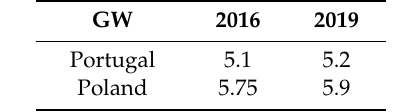
Table 1. Wind power installed capacity in Portugal and Poland in GW (2016 and 2019).